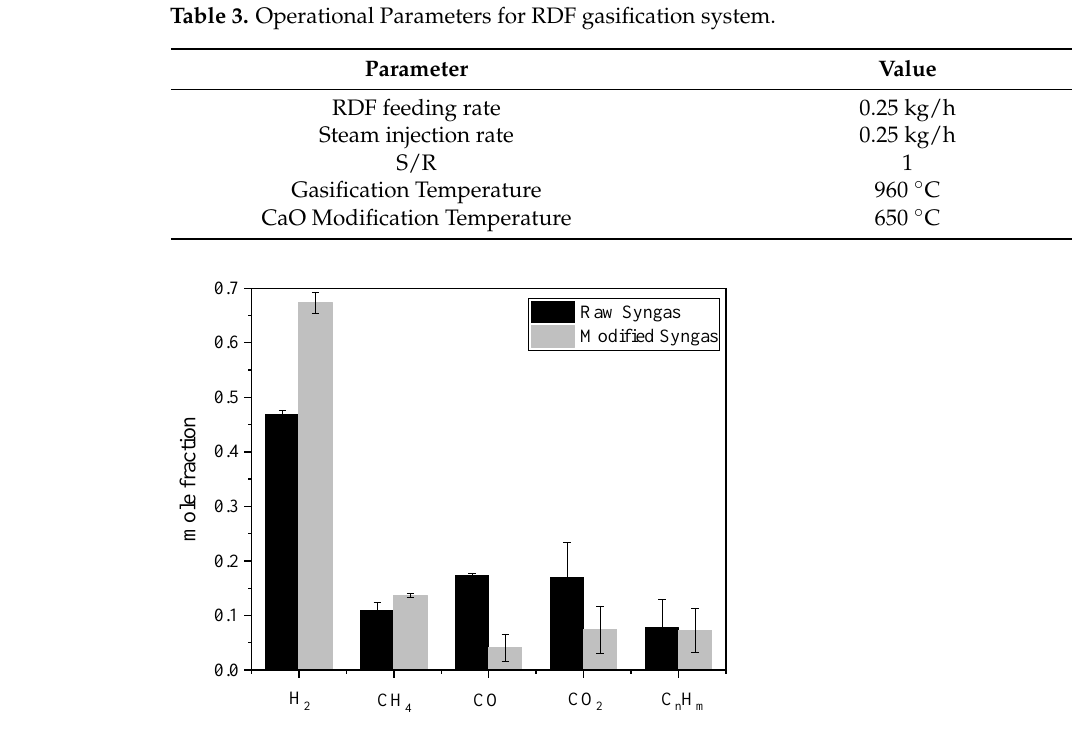
Figure 6. LHV and yield of the raw syngas and modified syngas. 3.1.2. Effect of Gasification Temperature The effect of gasification temperature on the syngas performance was investigated by varying the gasifier temperature at 660, 760, 860, and 960 °C. The gas product distribu- tion of the raw syngas and modified syngas are shown in Figure 7. The increase in the gasification temperature is more conducive to the endothermic methane dry reforming reaction (8), which converts CH 4 and CO 2 to H 2 . Increasing the gasification temperature